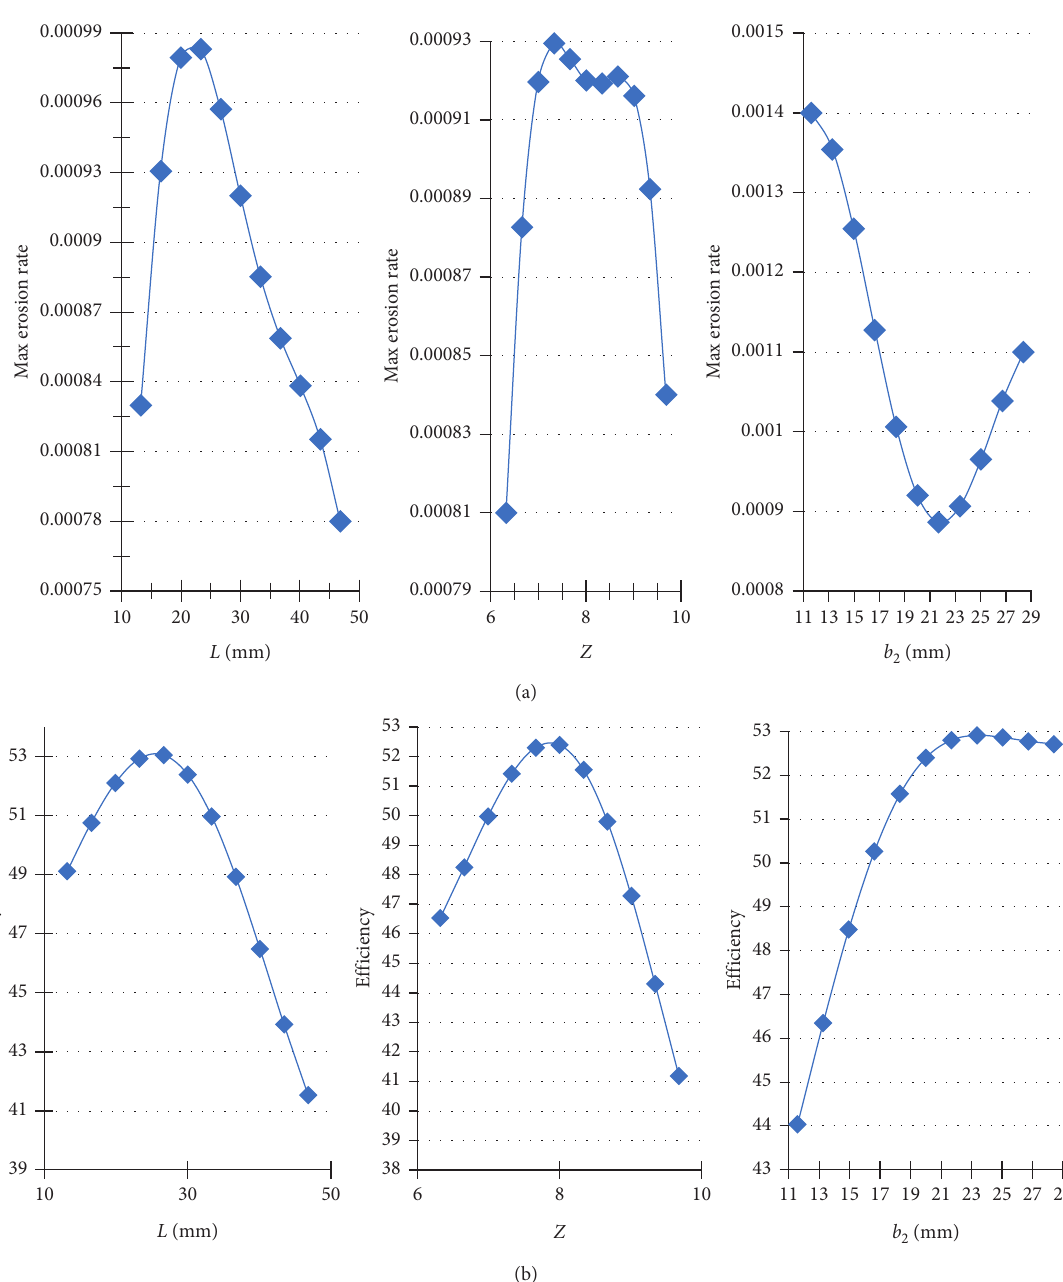
� 20mm, and Z � 8). (a) Maximum erosion rate. (b) 2